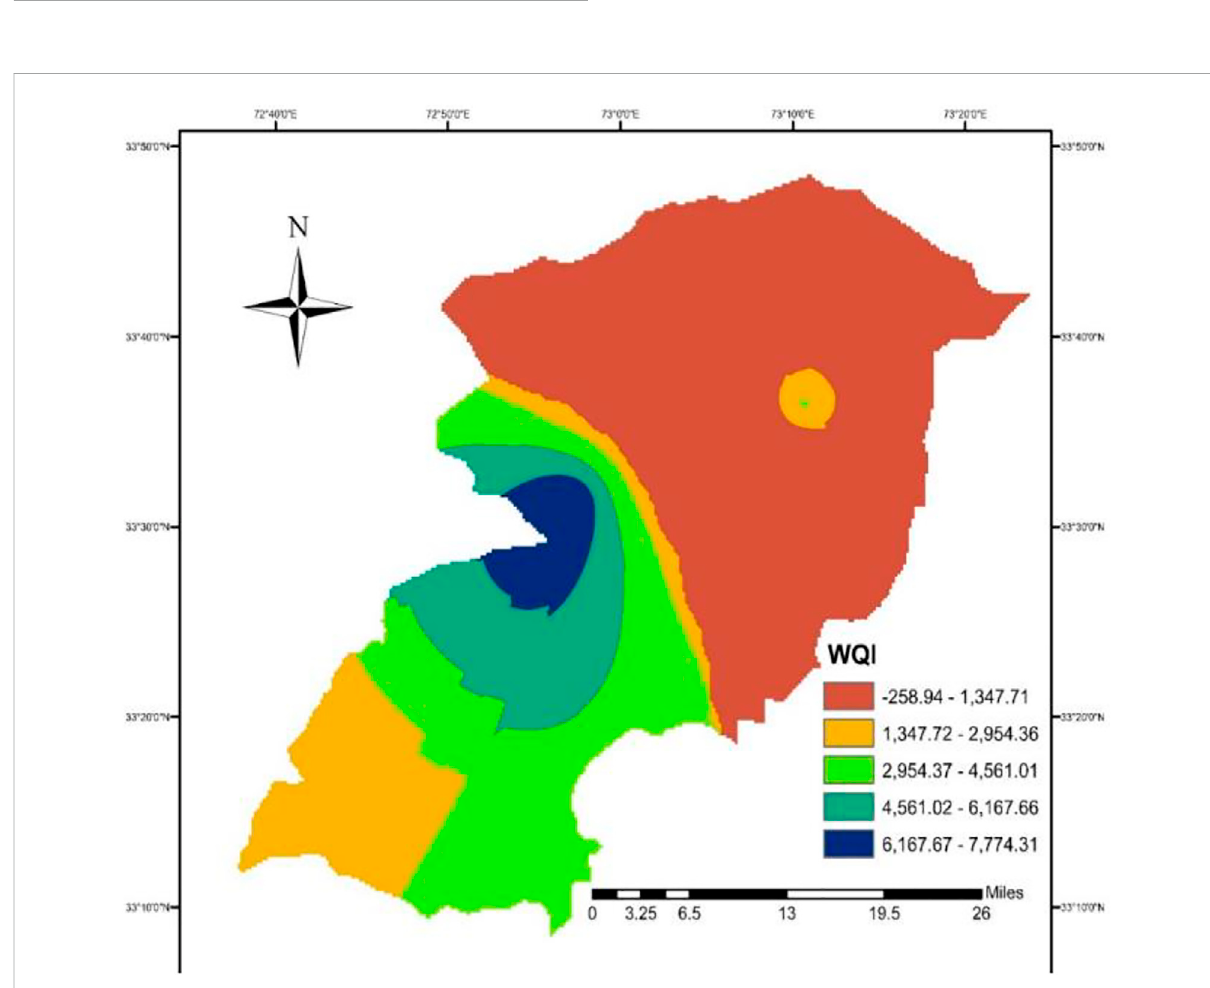
FIGURE 8 Spatial distribution of the groundwater quality index based on heavy metals in the “ twin cities.